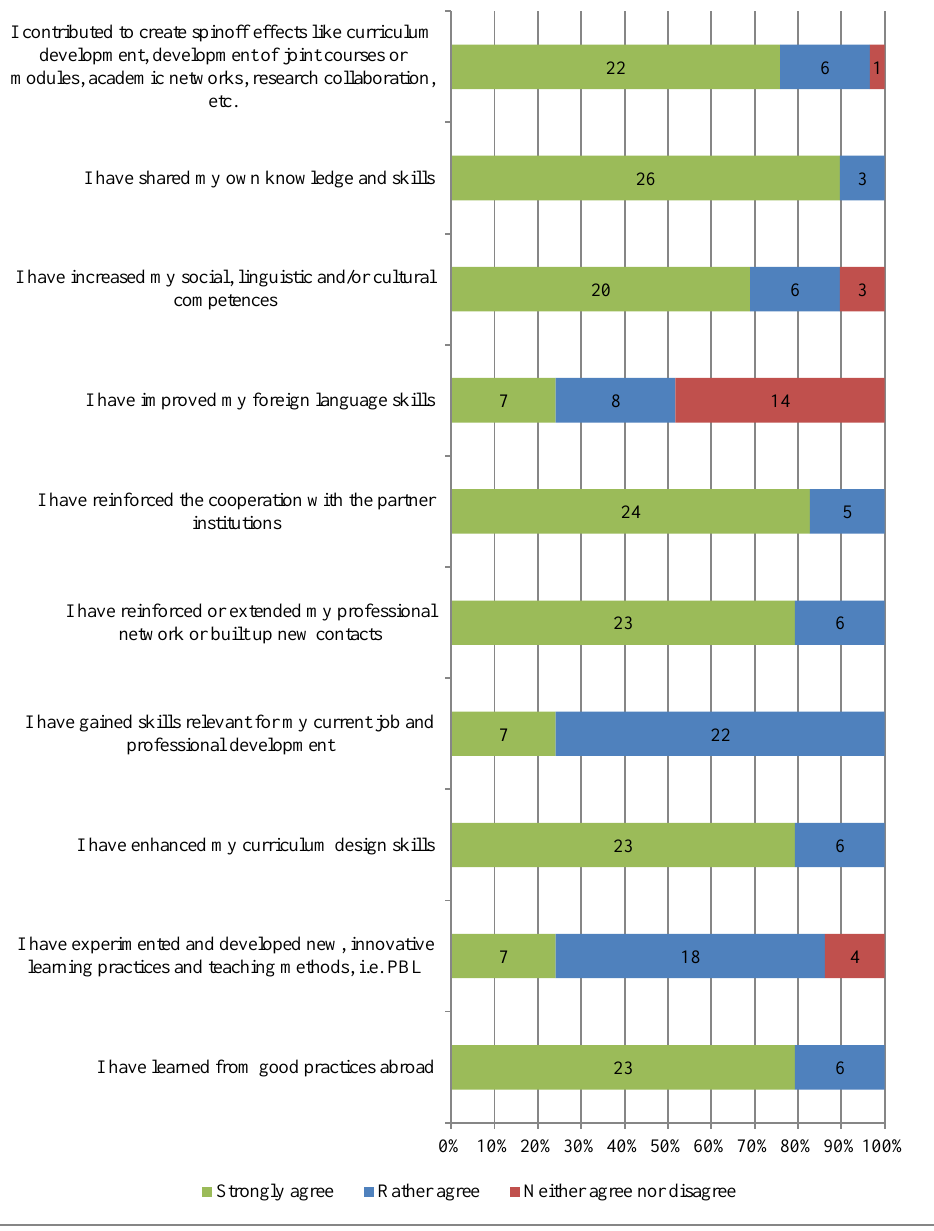
Fig. 3. Personal and professional achievements of teachers (developed by the authors, based on survey